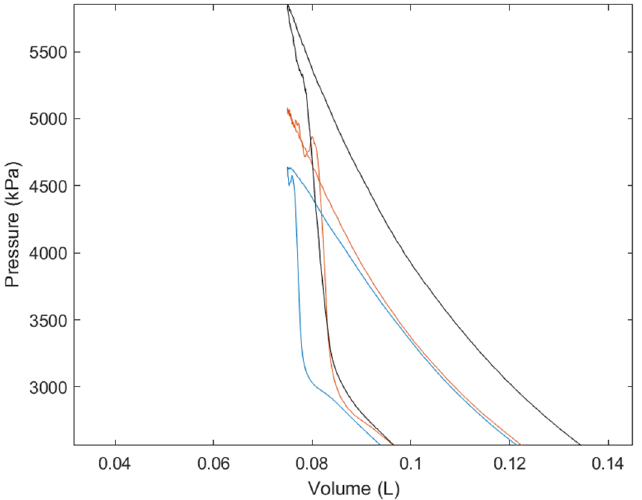
Figure 11. Top of the PV diagram of the original BSL case (black), RLE with original injection timing (red), and RLE with retarded timing (blue).